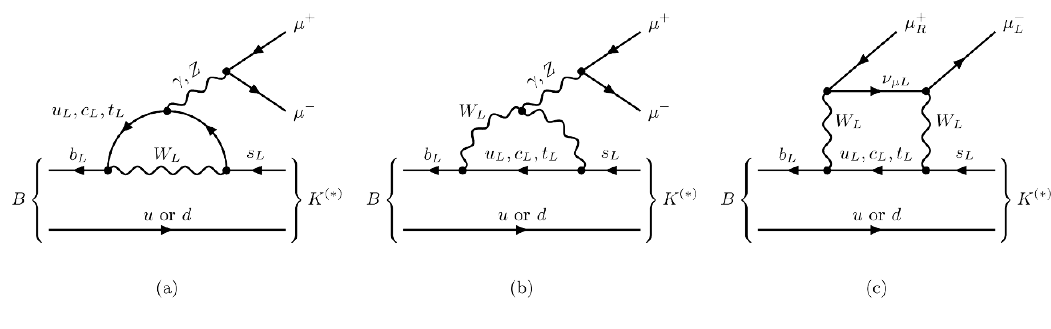
Figure 1 . SM processes that contribute to B ! K ( (cid:3) ) (cid:22) + (cid:22) (cid:0) . The muons in the (cid:12)nal states of (a) and (b) do not have de(cid:12)nite